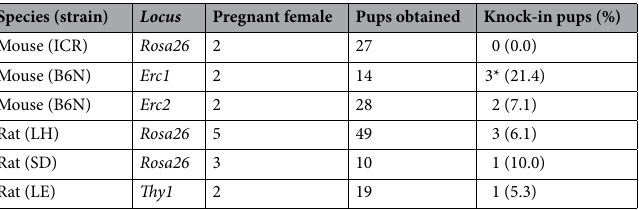
Table 1. Knock-in efficiency by in situ electroporation. *One of these pups harbored a homozygous mutation.